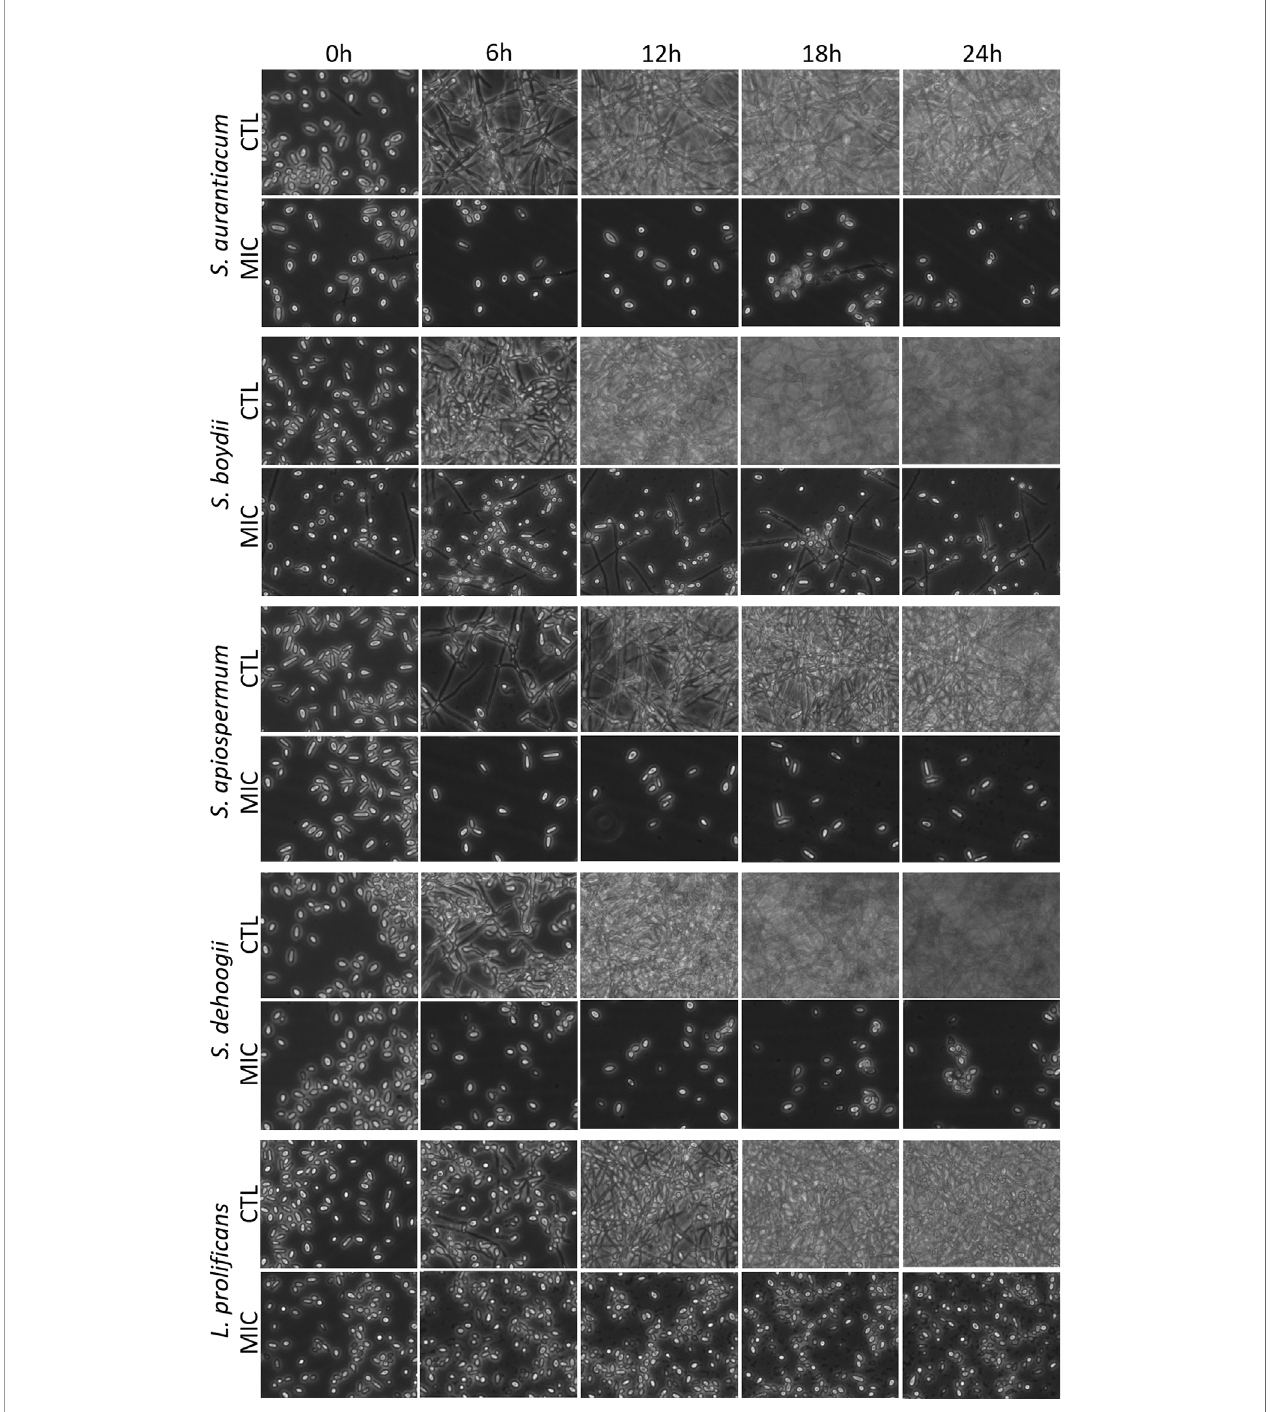
FIGURE 2 | Fungal germination in the absence or the presence of the minimum inhibitory concentration (MIC) of miltefosine. Cells were incubated at 37°C for up to 24 h; pictures were recorded every 6